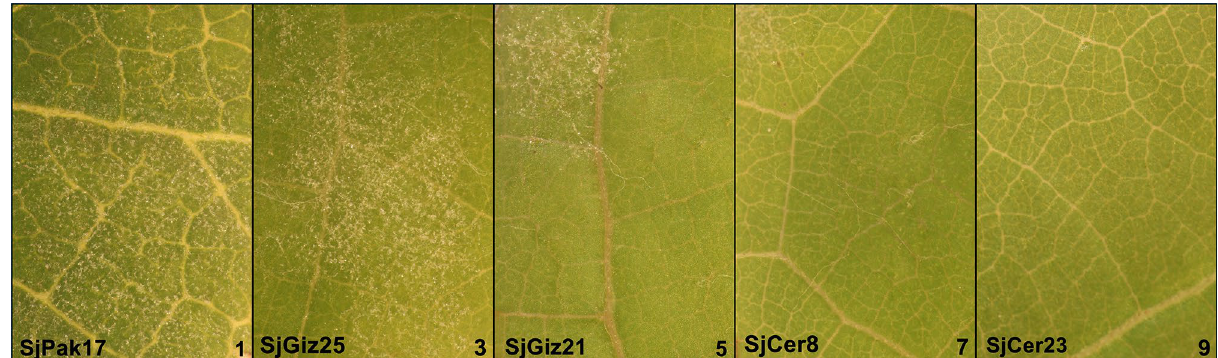
Figure 1. Grapevine powdery mildew ( E. necator ) mycelium development on V. sylvestris leaves. Powdery mildew spores were inoculated onto the top (adaxial) surface of leaf disks of V. sylvestris seedlings. Each figure represents fungal growth on a single leaf disk of five different genotypes according to the OIV 455 scale from 1 to 9 (left to right), respectively. The PM-susceptible seedlings received a lower scale number, while resistant seedlings received a higher